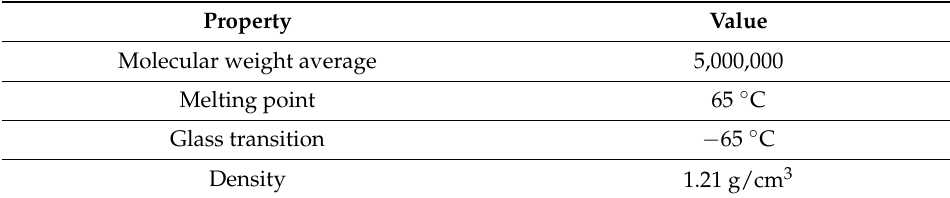
Table 1. Basic properties of PEO.